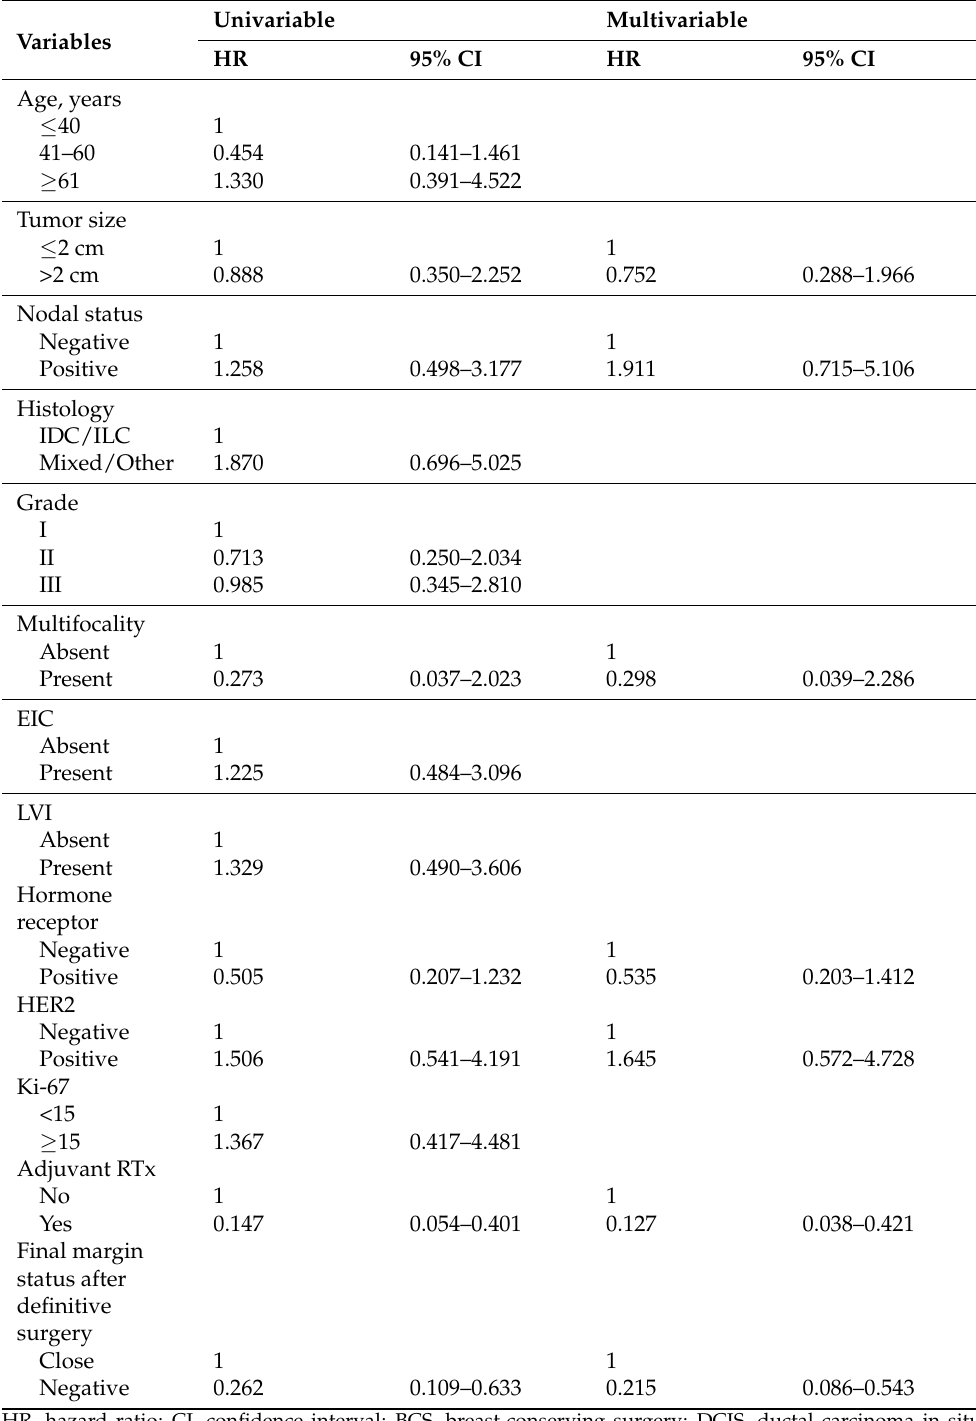
Table 3. Cox proportional hazard model of risk factors associated with locoregional